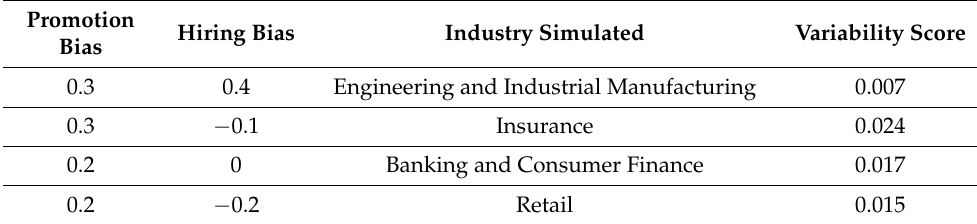
Table 3. Bias parameters and simulation accuracy for the four industries simulated in Experiment 2.